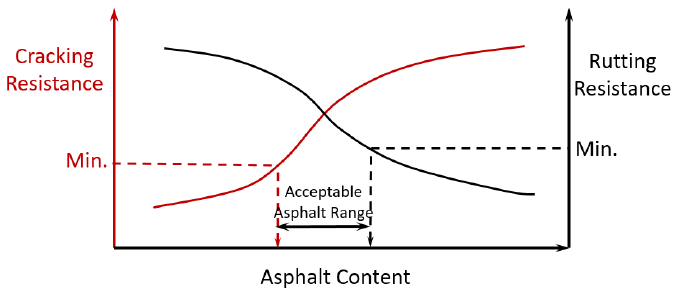
Figure 9. Concept of balanced mix design (BMD).